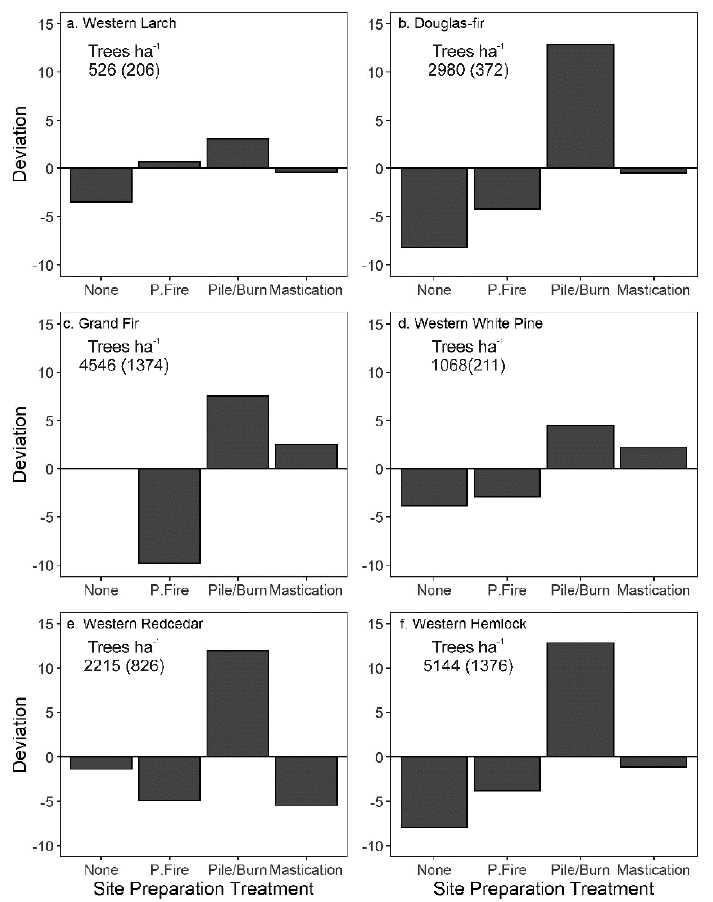
Figure 3. Chi-gram illustrating the difference in regeneration establishment for different site preparation methods for six conifer species. The six species are western larch ( a ), Douglas-fir ( b ), grand fir ( c ), western white pine ( d ), western redcedar ( e ) and western hemlock ( f ). Chi-grams illustrate expected versus observed. Expected values are 0 compared to the observed deviation which are either equal to the expected or more or less abundant than the expected. Chi-square goodness-of-fit was p = 0.0001. Note that “P.Fire” on graphs refers to Prescribed Fire. Trees ha − 1 are means and standard errors in parentheses.